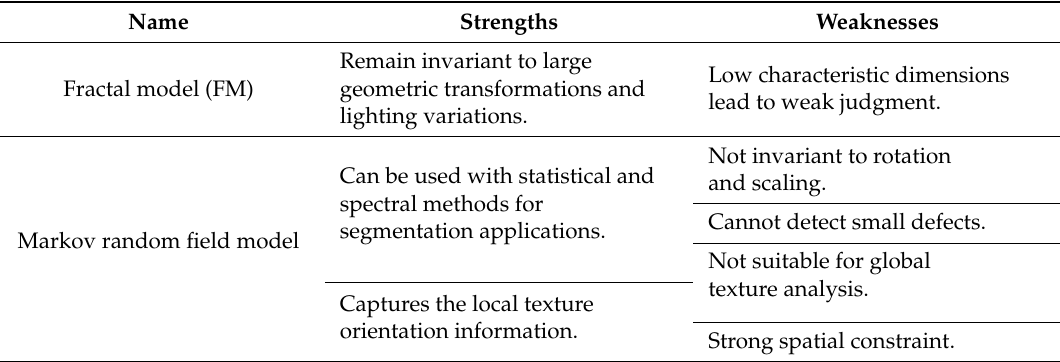
Table 4. Strengths and weaknesses of model-based detection methods for steel